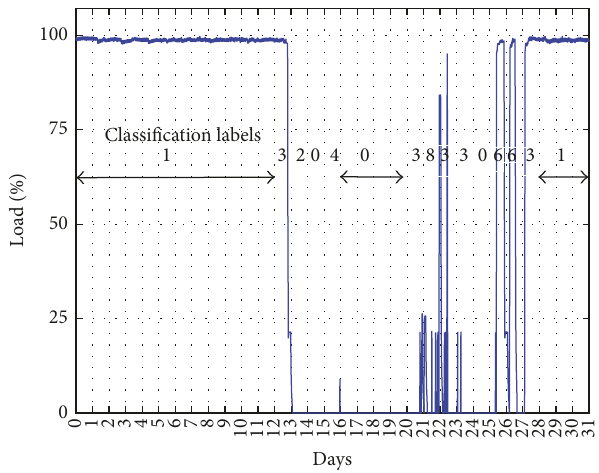
Figure 4: [CS1] Plot of vibration measurements versus time (days) (month 1—normal operation).